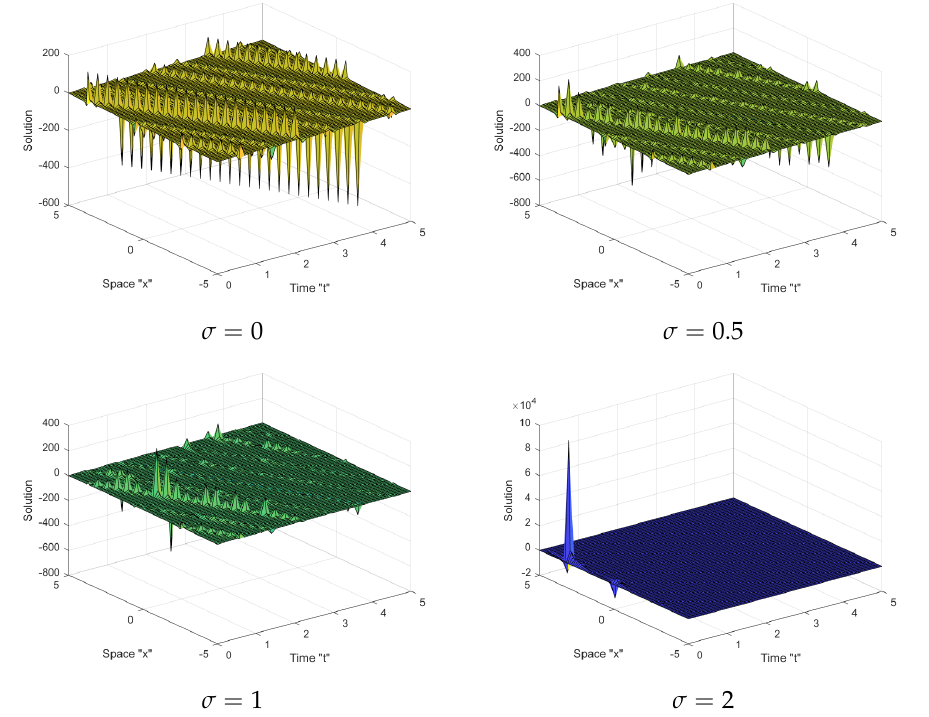
Figure 1. 3D plot of the obtained solution ϕ 1,3 ( x ,1, t ) of Equation